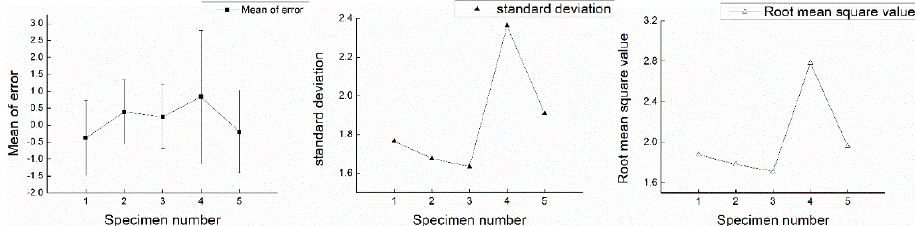
Figure 7. The average value of the error, standard deviation, and root mean square value of each specimen.